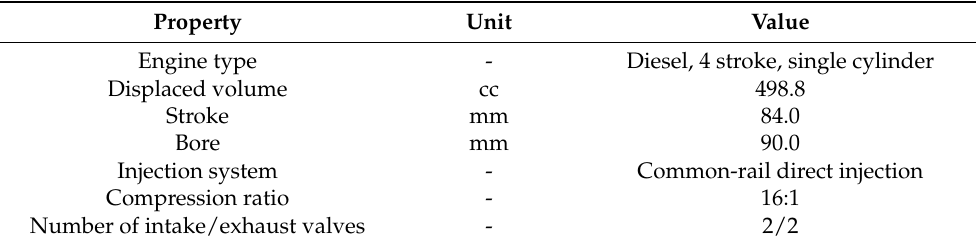
Table 2. Specifications of 0.5 L single-cylinder diesel